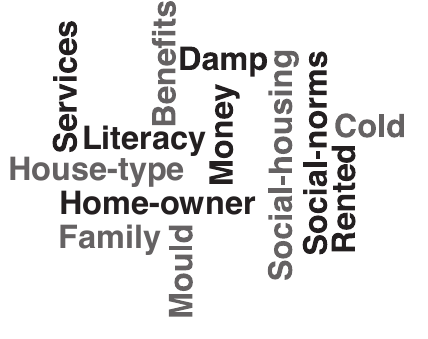
Figure 4. The contextual factors - a word cloud